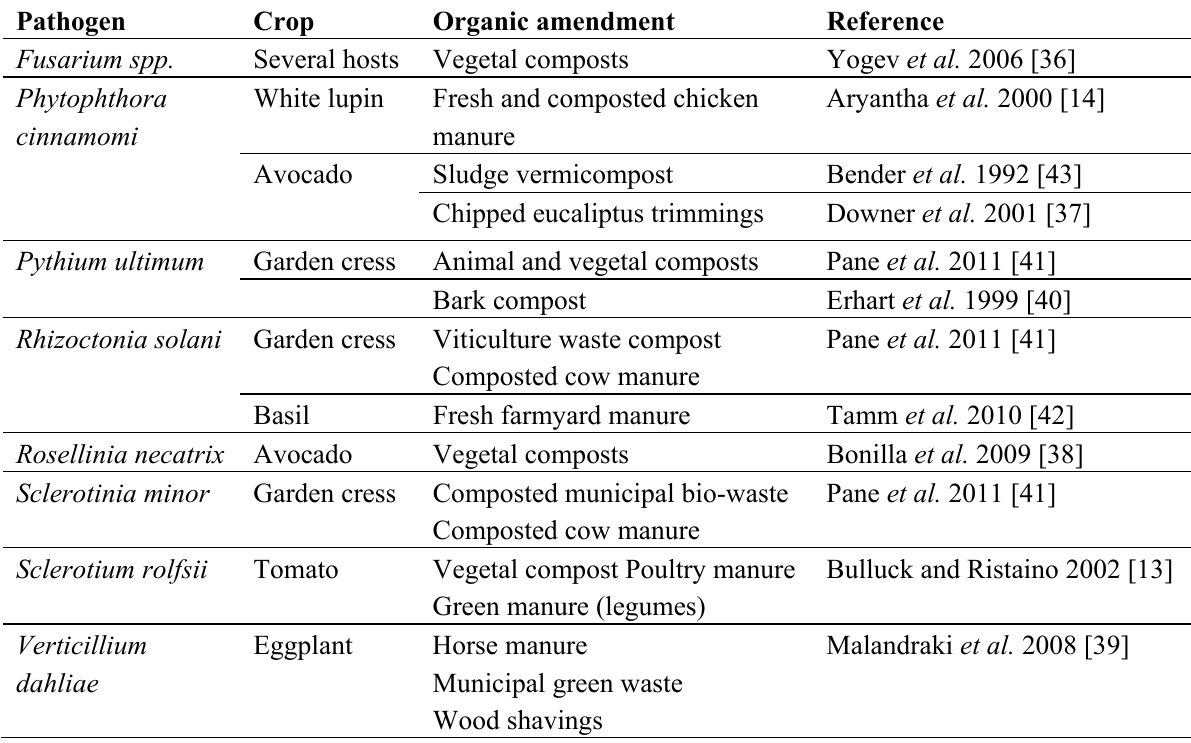
Table 1. Examples of proven plant disease suppression following application of organic